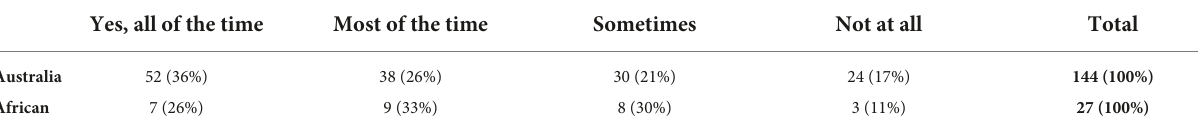
TABLE 7 Supervisor